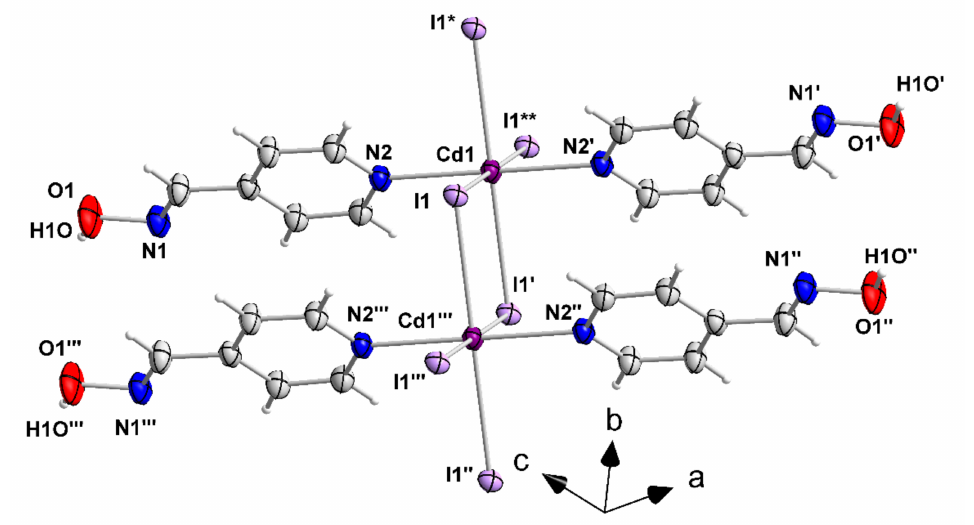
Figure 8. A small portion of the 1D chain that is present in the crystal structure of {[CdI 2 (4paoH) 2 ]} n ( 3 ). The thermal ellipsoids are presented at the 50% probability level. Only the Cd II atoms, the donor atoms and the N, O atoms of the oxime groups are numbered. Symmetry